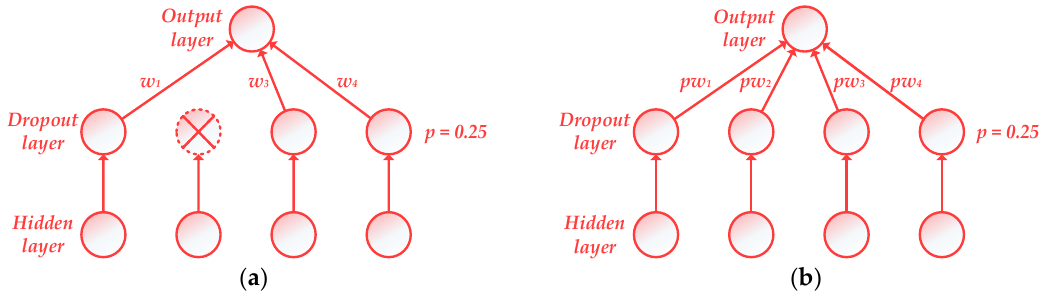
Figure 5. A dropout layer with rate p = 0.25. ( a ) dropout during the training phase; ( b ) dropout during the testing phase.